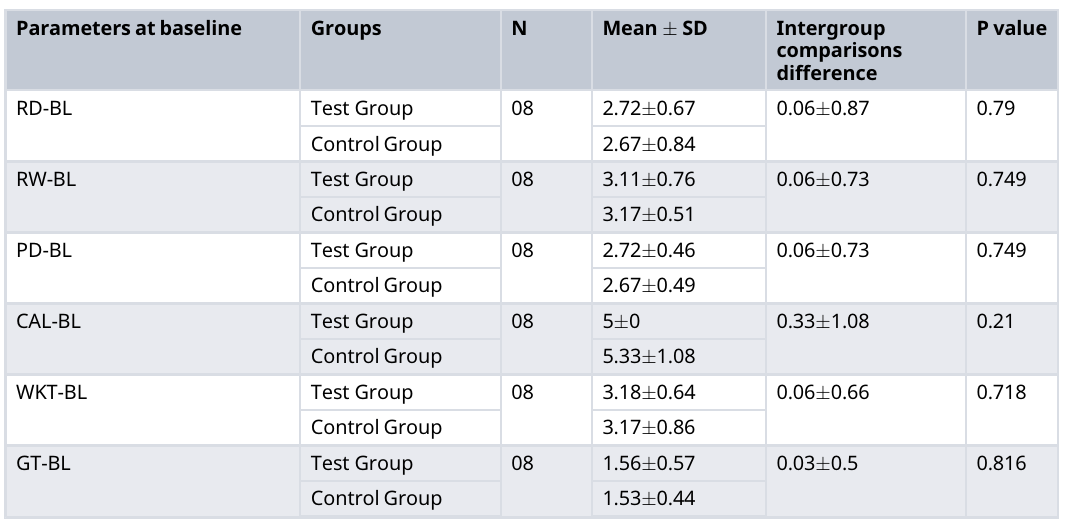
Table 3. Baseline characteristics of test and control groups.